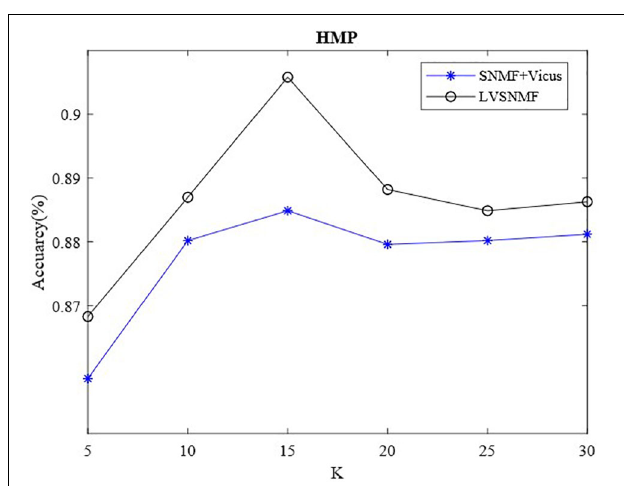
FIGURE 3 | The performance of LVSNMF varies as K